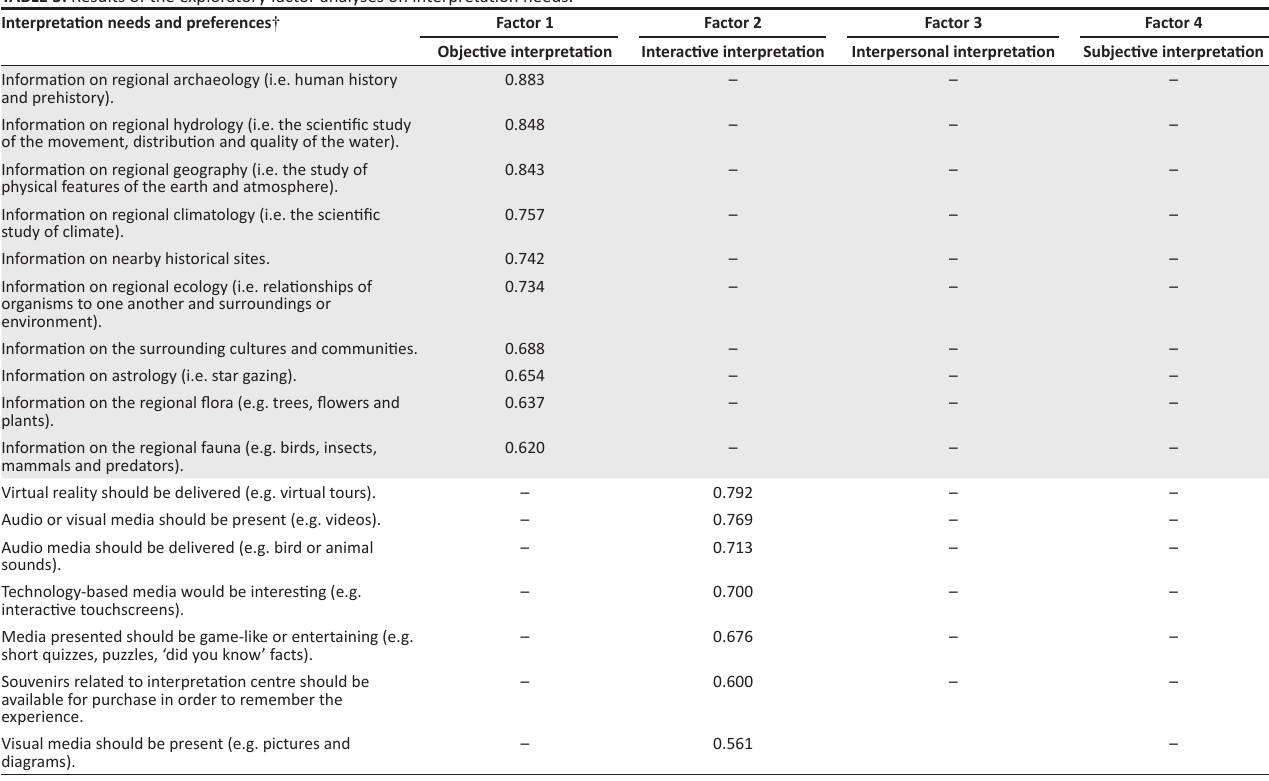
TABLE 5: Results of the exploratory factor analyses on interpretation needs. Interpretation needs and preferences